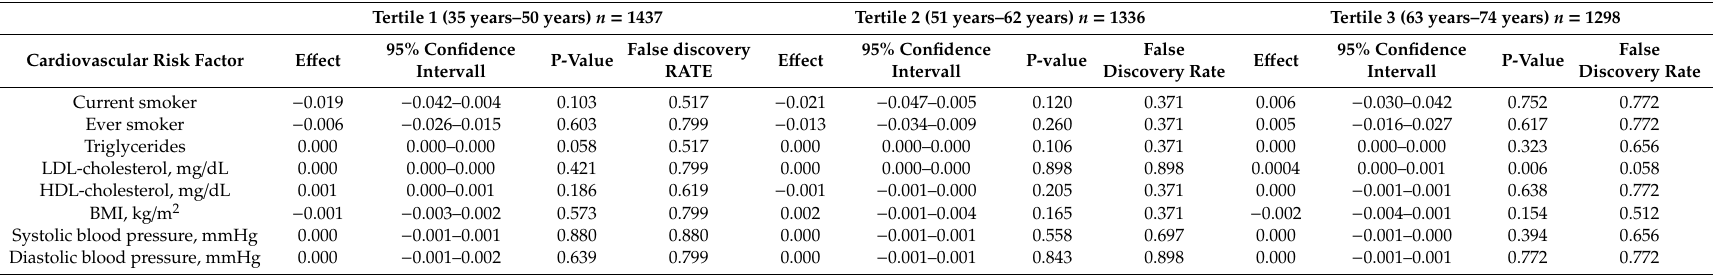
Table 3. Multivariable linear regression of relative telomere length on cardiovascular risk factors according to tertiles of age. Relative telomere length was adjusted for age, batch, and PCR